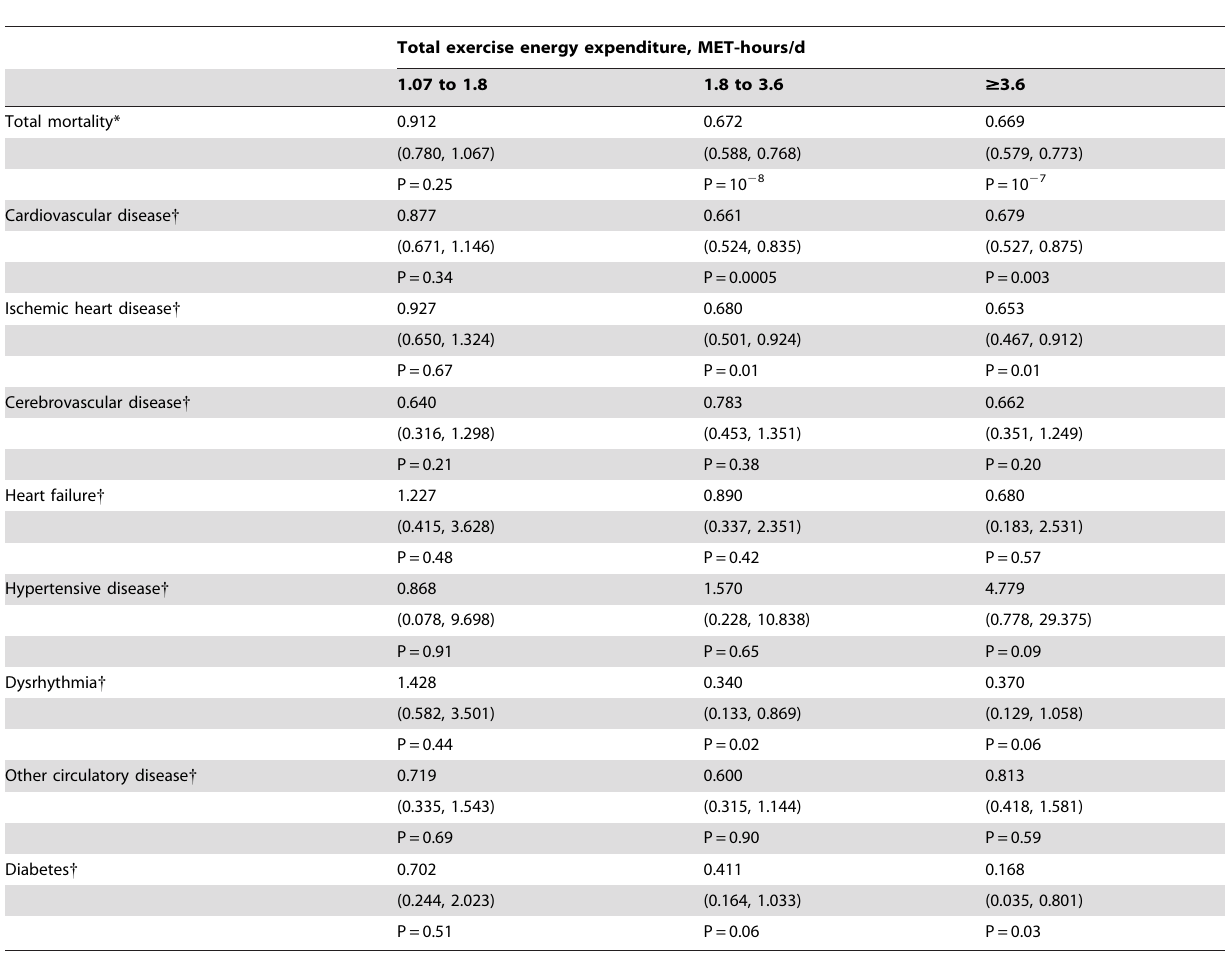
Table 5. Survival analyses of underlying cause of death vs. categories of physical activity adjusted for medication use and BMI starting walking